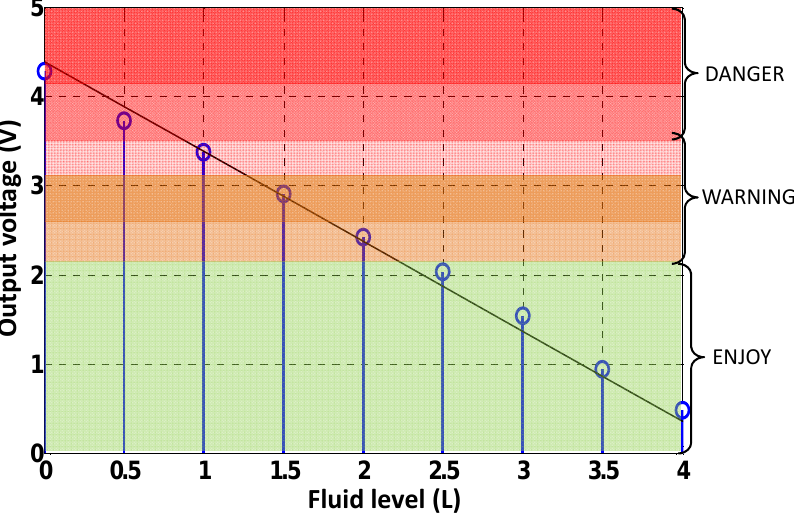
Figure 6. Calibration curve of the sensor prototype versus fuel level. Linear regression of the output voltage from the signal conditioning stage is represented in solid